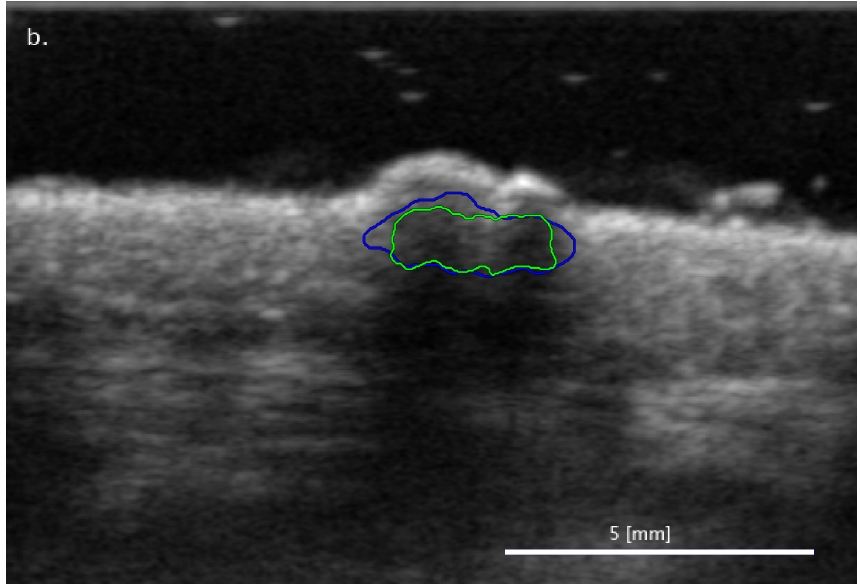
Figure 4. Examples of images with segmentation results leading to a different ‘Nevus vs. others’ type binary classification in the case of the SA methods (freehand: blue mark; LAR: green mark). Two typical cases are presented: ( a ) freehand segmentation leads to correct classification, but LAR-based segmentation detects the lesion only partially so its classification fails; ( b ) SA freehand segmentation fails because of arbitrary boundary selection, but the ACM model, used by SA LAR, corrects the mistake.